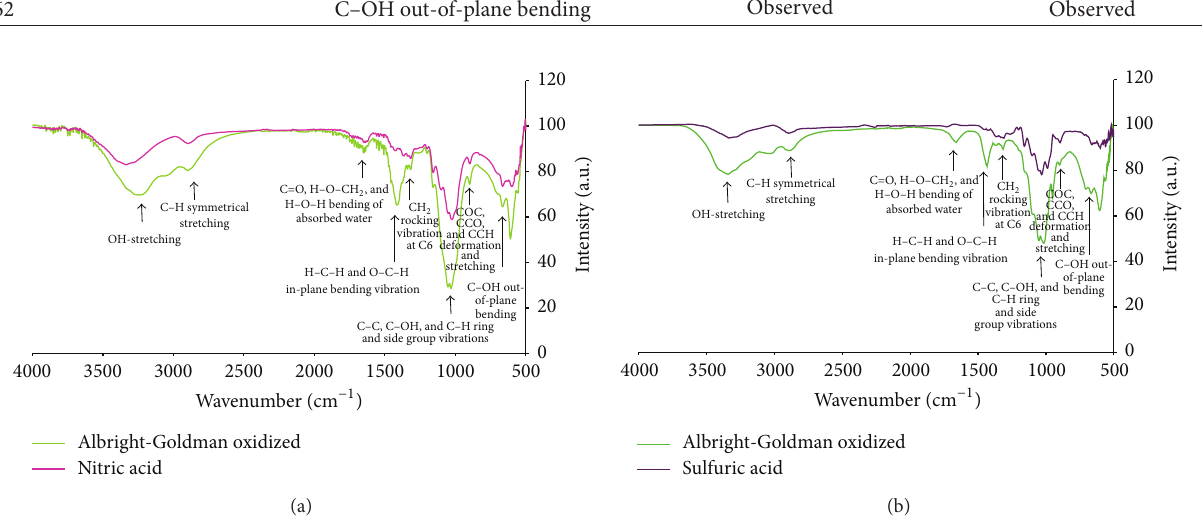
Figure 4: Fourier transform infrared spectroscopy (FTIR) spectra of nitric acid (a) and sulfuric acid (b) extracted cellulose and its Albright- Goldman modified counterparts.